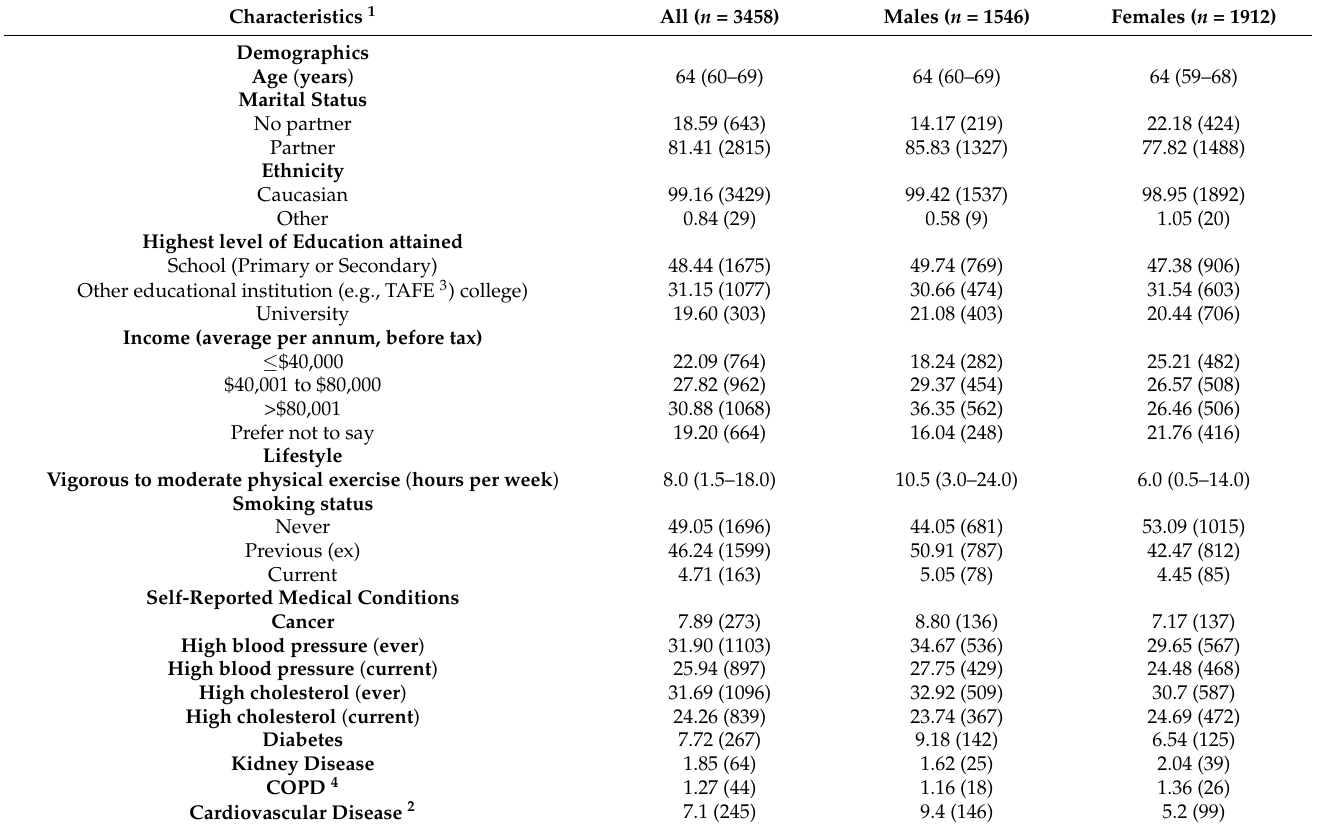
Table 1. Participant characteristics, including demographics, lifestyle factors and self-reported medical conditions, by sex (males/females) and for the cohort as a whole (all). Characteristics